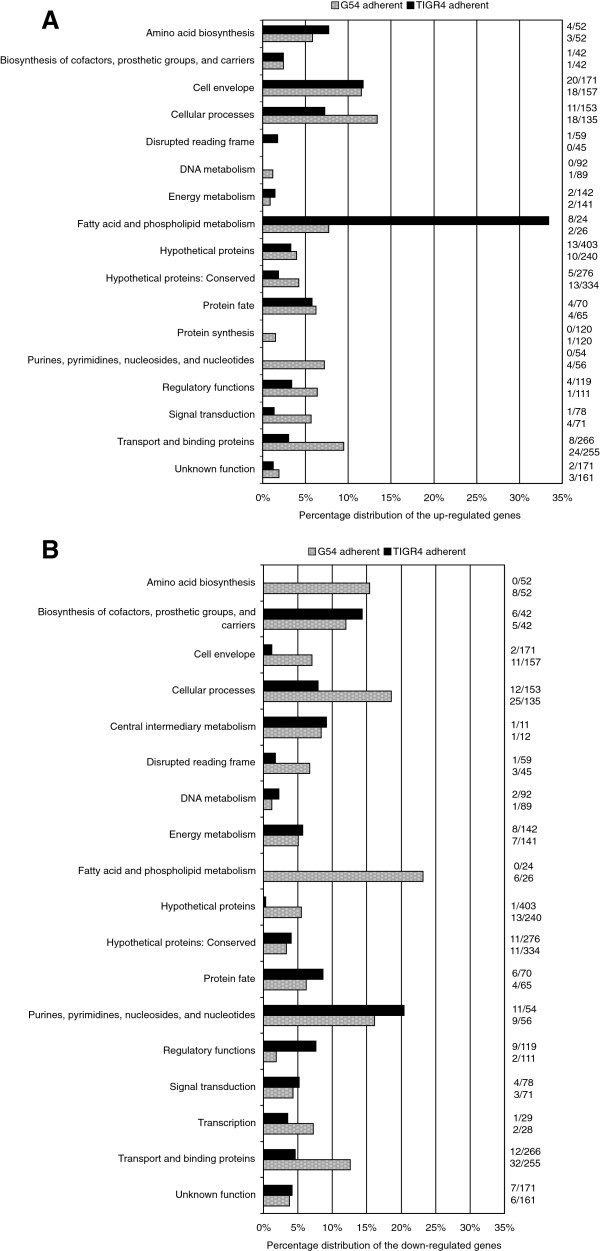
Functional categories of differentially expressed genes in the adherent fraction of TIGR4 and G54. A. Percentage distribution of the up-regulated genes, B. Percentage distribution of the down-regulated genes. TIGR4 genes are depicted as black bars and G54 genes as grey bars. The percentage of genes up- or down-regulated is based on the total number of genes in the genome assigned to a particular category. The numbers on the right show the fractions from where these percentages were derived.